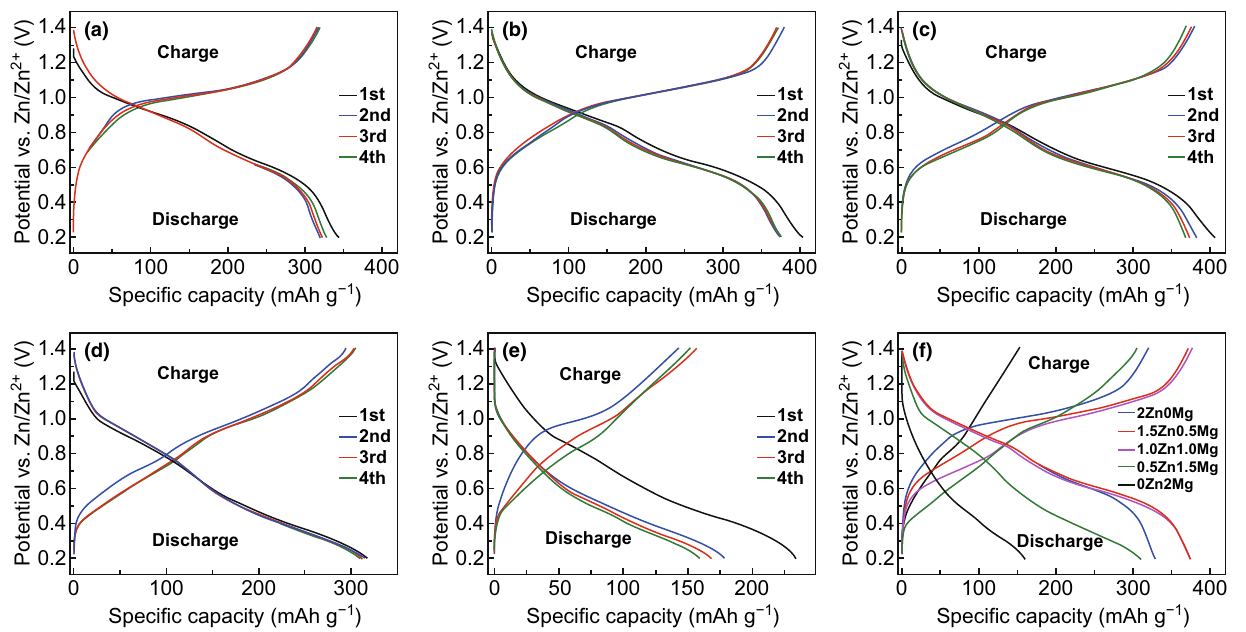
Fig. 3 Discharge–charge profiles for MgVO cathode at current density of 100 mA g −1 in different electrolytes: a 2.0 M ZnSO 4 , b 1.5 M ZnSO 4 –0.5 M MgSO 4 , c 1.0 M ZnSO 4 –1.0 M MgSO 4 , d 0.5 M ZnSO 4 –1.5 M MgSO 4 , e 2.0 M MgSO 4 , and f the comparison of the fourth dis- charge–charge profiles in the five